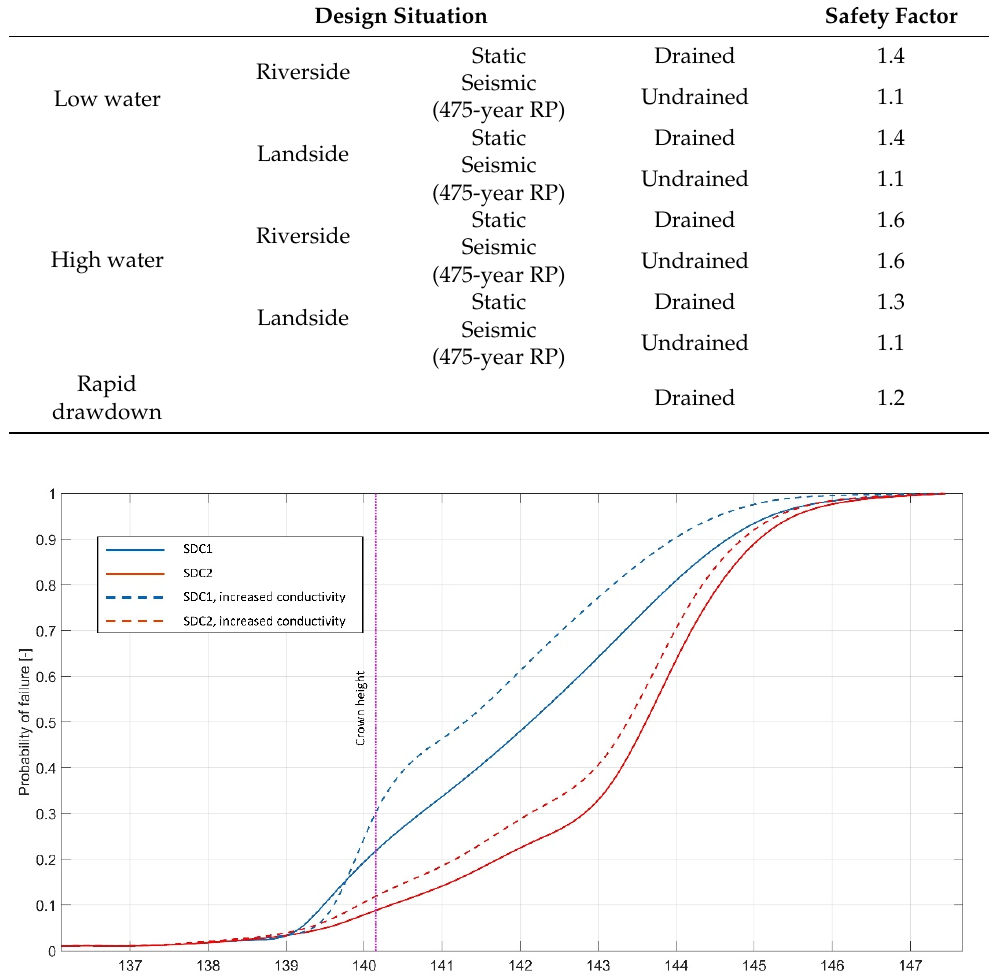
Table 3. Deterministic safety factors for the case study levee, exposed to various design situations.